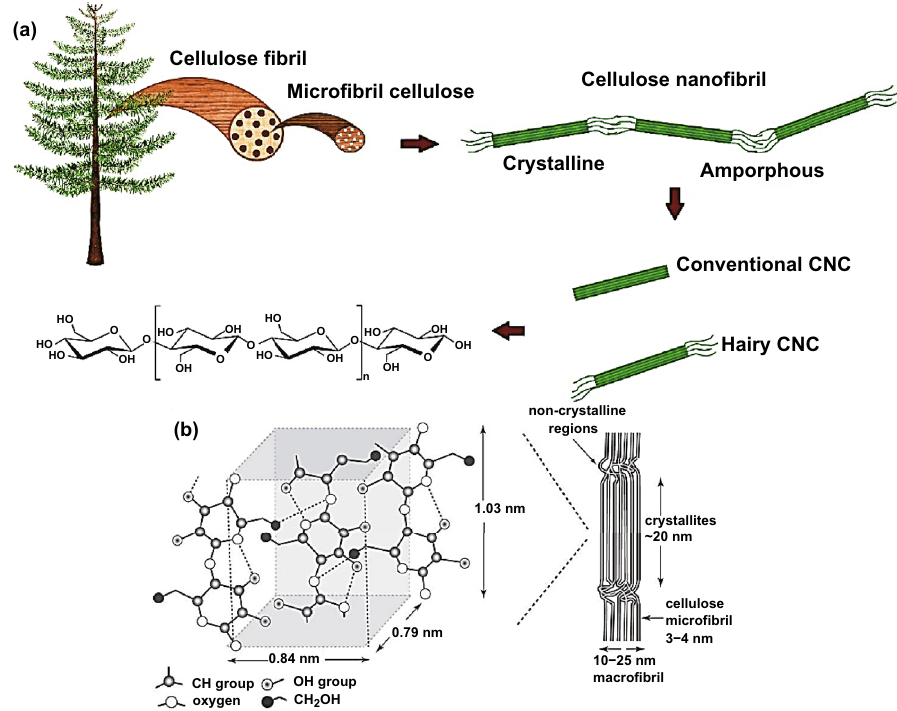
Fig. 1 a Schematic representation of top-down cellulose hierarchical structure from origin source. Reproduced with permission from Ref. [166] Copyright © 2020, Springer Nature. b Intra-intermolecular strong hydrogen bonding cellulose structure and glucose monomers alternately rotated degree (180°) with crystalline-non-crystalline regions. Reproduced with permission from Ref. [167] Copyright © 2012, The Royal Soci-